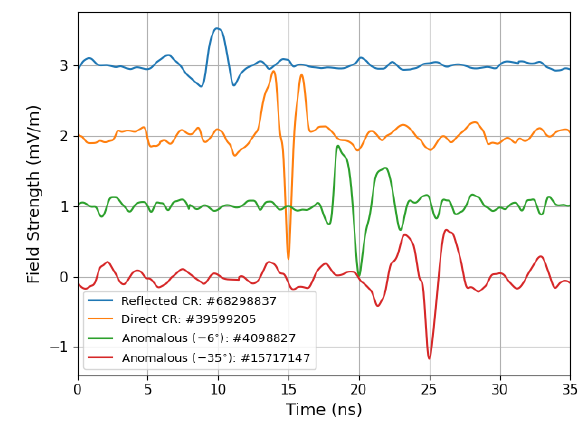
Figure 2. Four candidate H-Pol signals from di ff erent event clas- si fi cations observed during the fl ights of ANITA, superimposed on the same plot, shifted in time and fi eld strength for clarity. The four event classi fi cations shown are: i) re fl ected cosmic rays, ii) direct (above-the-horizon) cosmic rays iii) slightly below hori- zon upgoing EAS iv) steeply upgoing EAS [2–4].